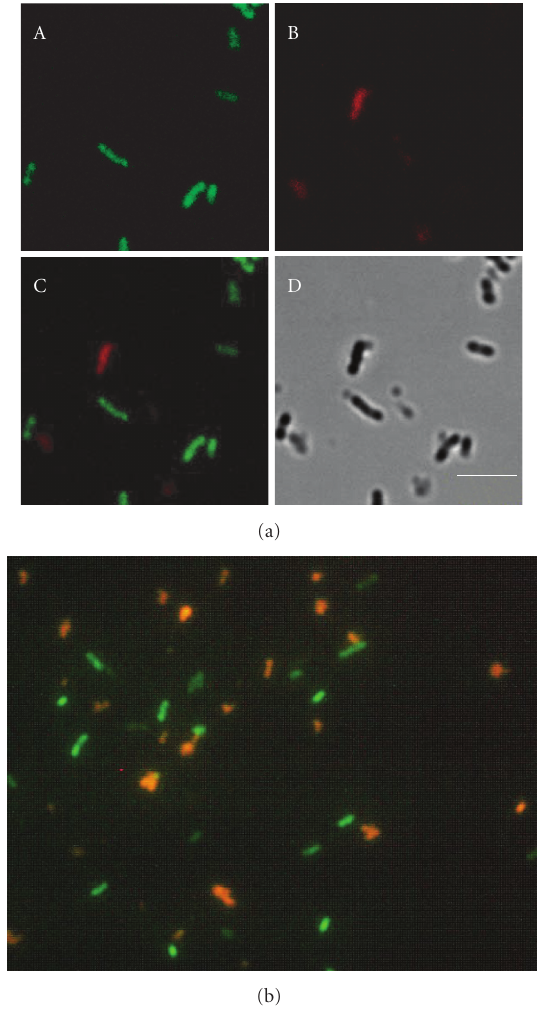
Figure 4: Detection of M. tuberculosis in mixed bacterial samples with the FNP-IIFM method. A mixture containing 1 . 8 × 10 6 cells/ml FITC-labeled E. coli and 3 . 6 × 10 5 cells/ml unlabeled M. tuberculosis was detected. (a) Confocal microscopic images (60 × oil): (A)